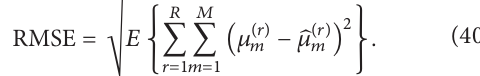
has direction of arrival {𝛼 𝑚 , 𝛽 𝑚 } 𝑀 𝑚=1 , where 𝛼 𝑚 and 𝛽 𝑚 are elevation and azimuth angles, respectively.